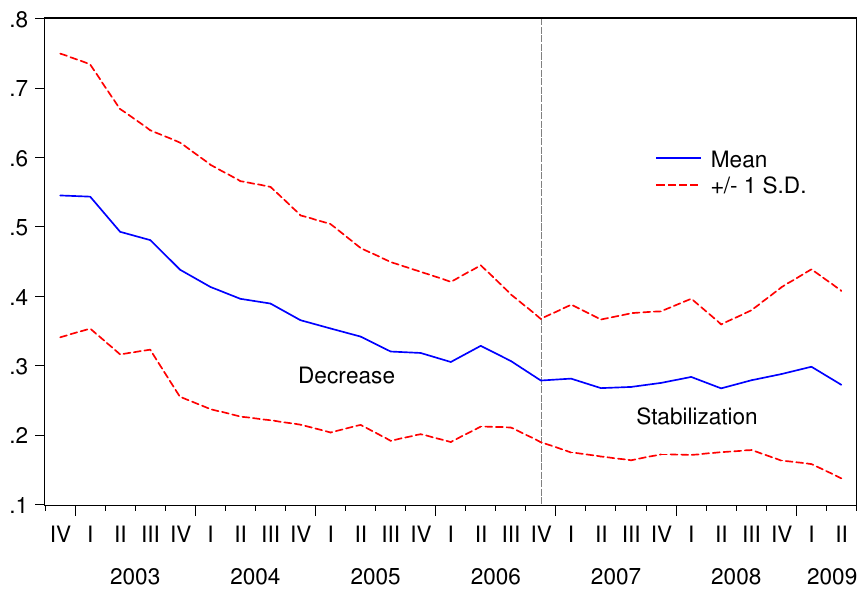
Figure 1. Foreign currency (FC) loans to total loan portfolio in the Turkish banking